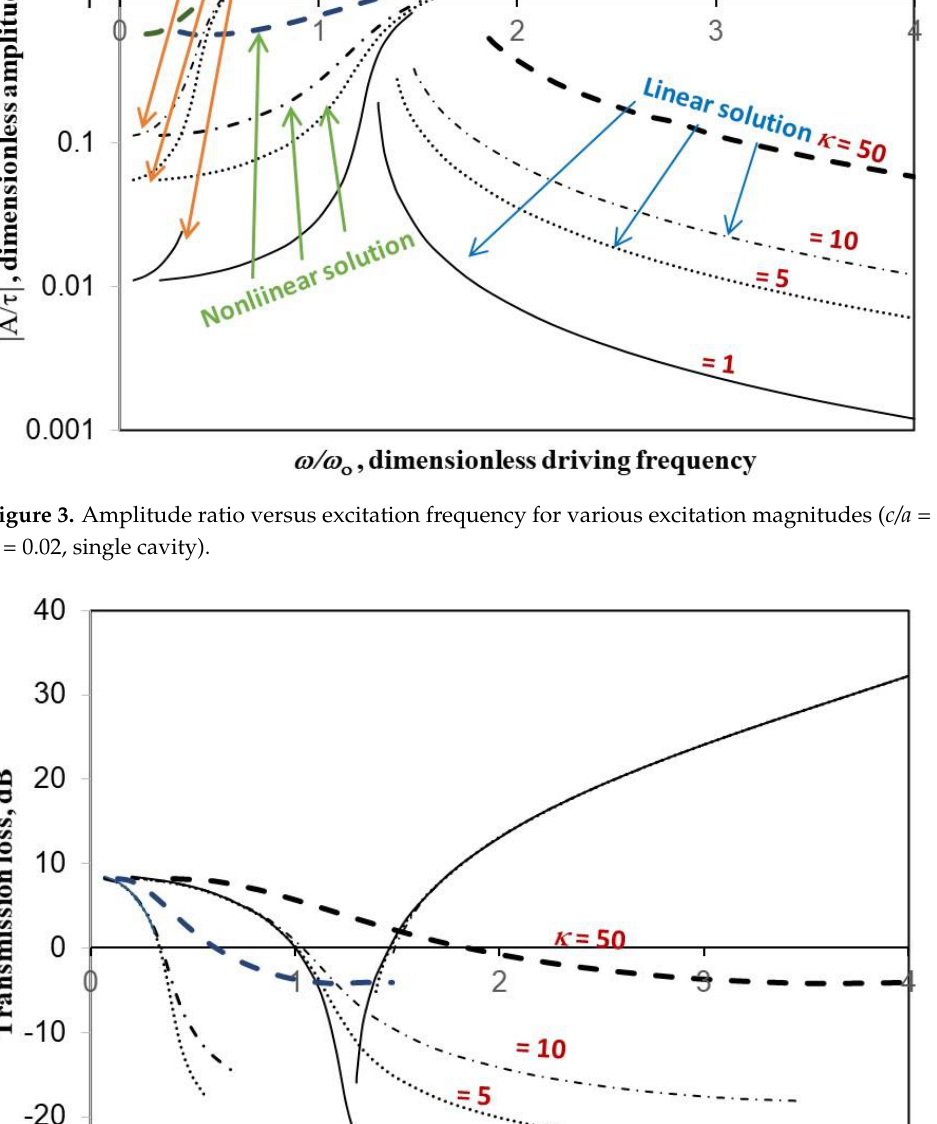
Figure 4. Transmission loss ratio versus excitation frequency for various excitation magnitudes ( c/a = 0.5, ξ = 0.02, single cavity).